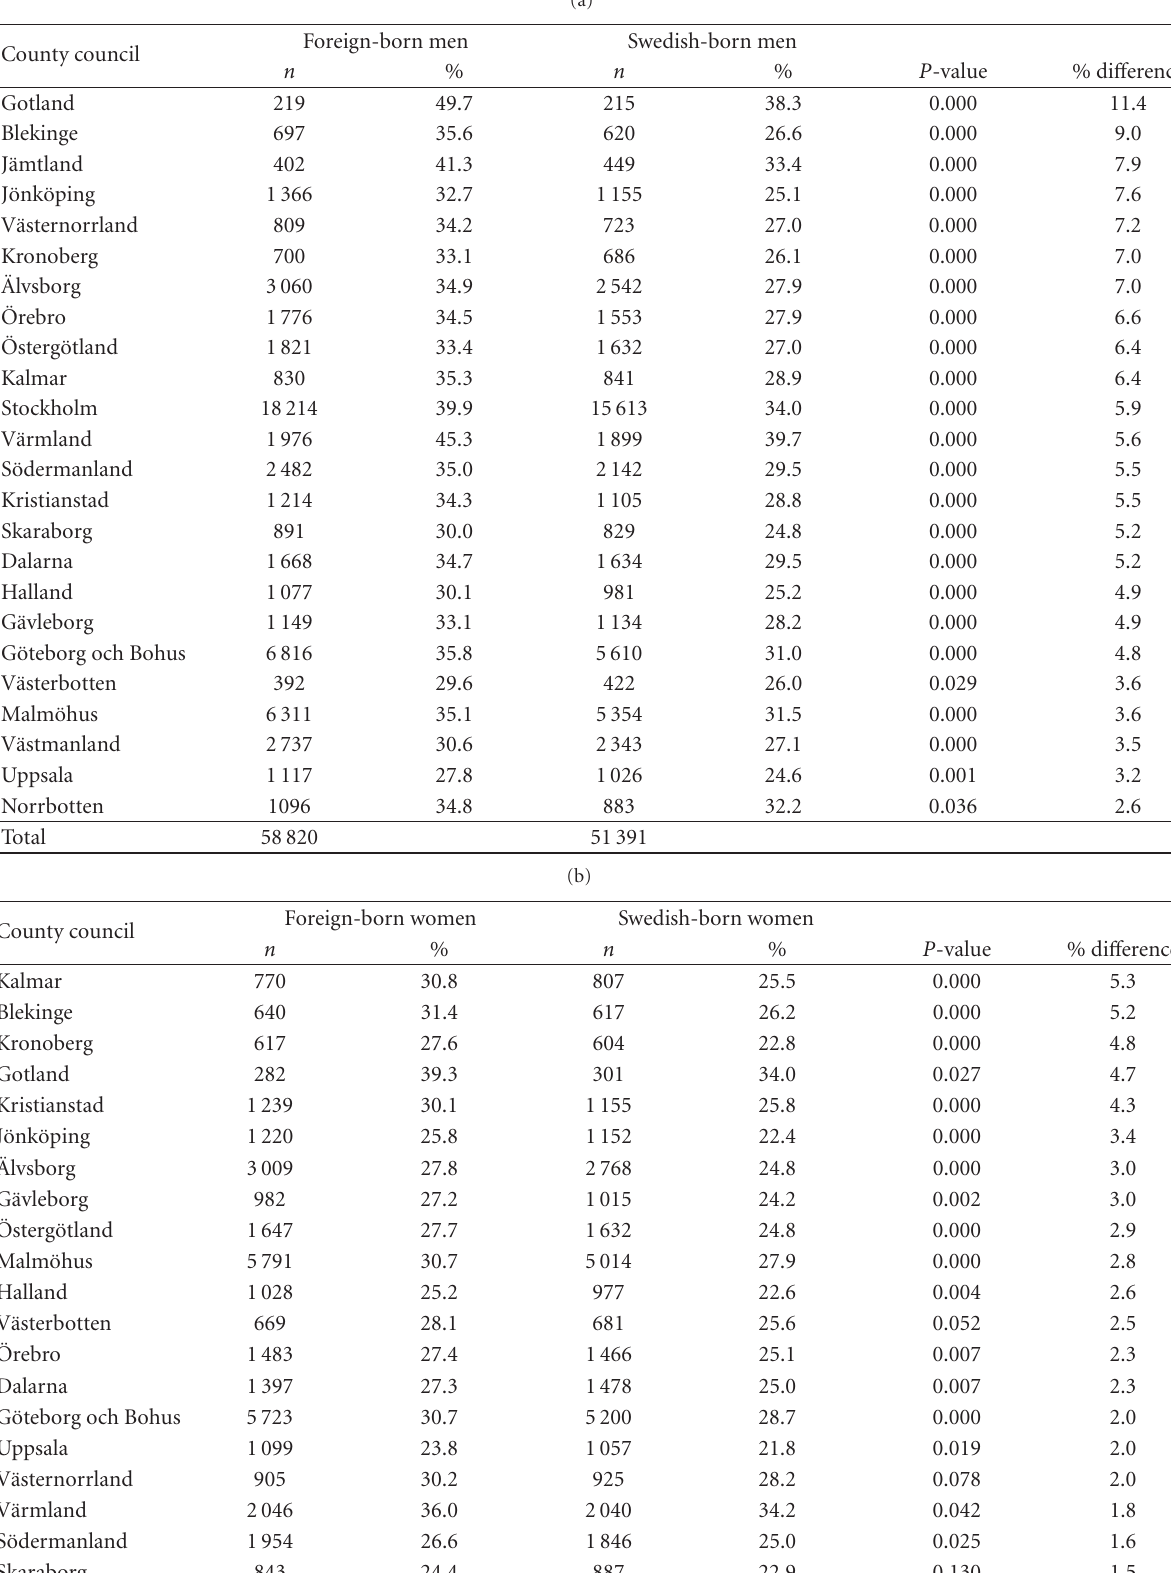
Table 4: (a) Deceased men in relation to latest county council of residence, (b) Deceased women in relation to latest to county council of